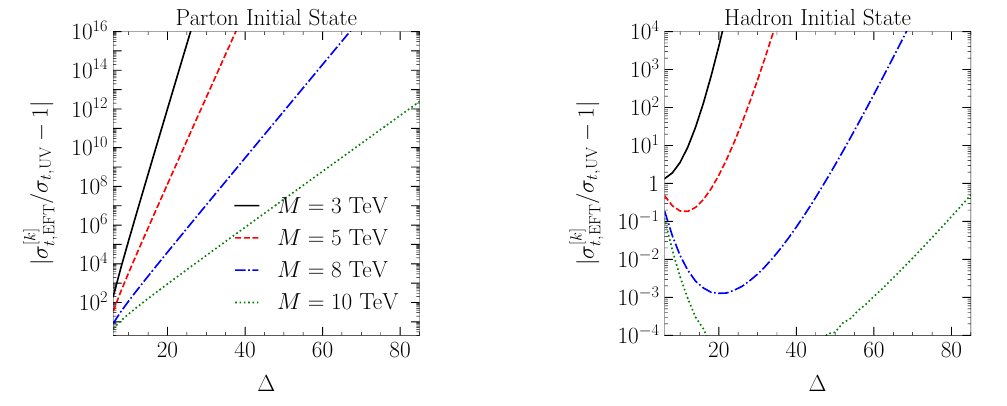
Figure 10 . The absolute value of the relative error (see eq. (5.10)) computed for the t -channel model as a function of the EFT truncation dimension ∆ . For the “Partonic Initial State” case [left], √ we present curves for M < ˆ s = 14 TeV, which show that the error grows monotonically as ∆ is increased. In the “Hadronic Initial State” case [right], we present curves for M < which show that the EFT approximation improves for small values of ∆ , but then the error begins to grow for ∆ > ∆ crit .